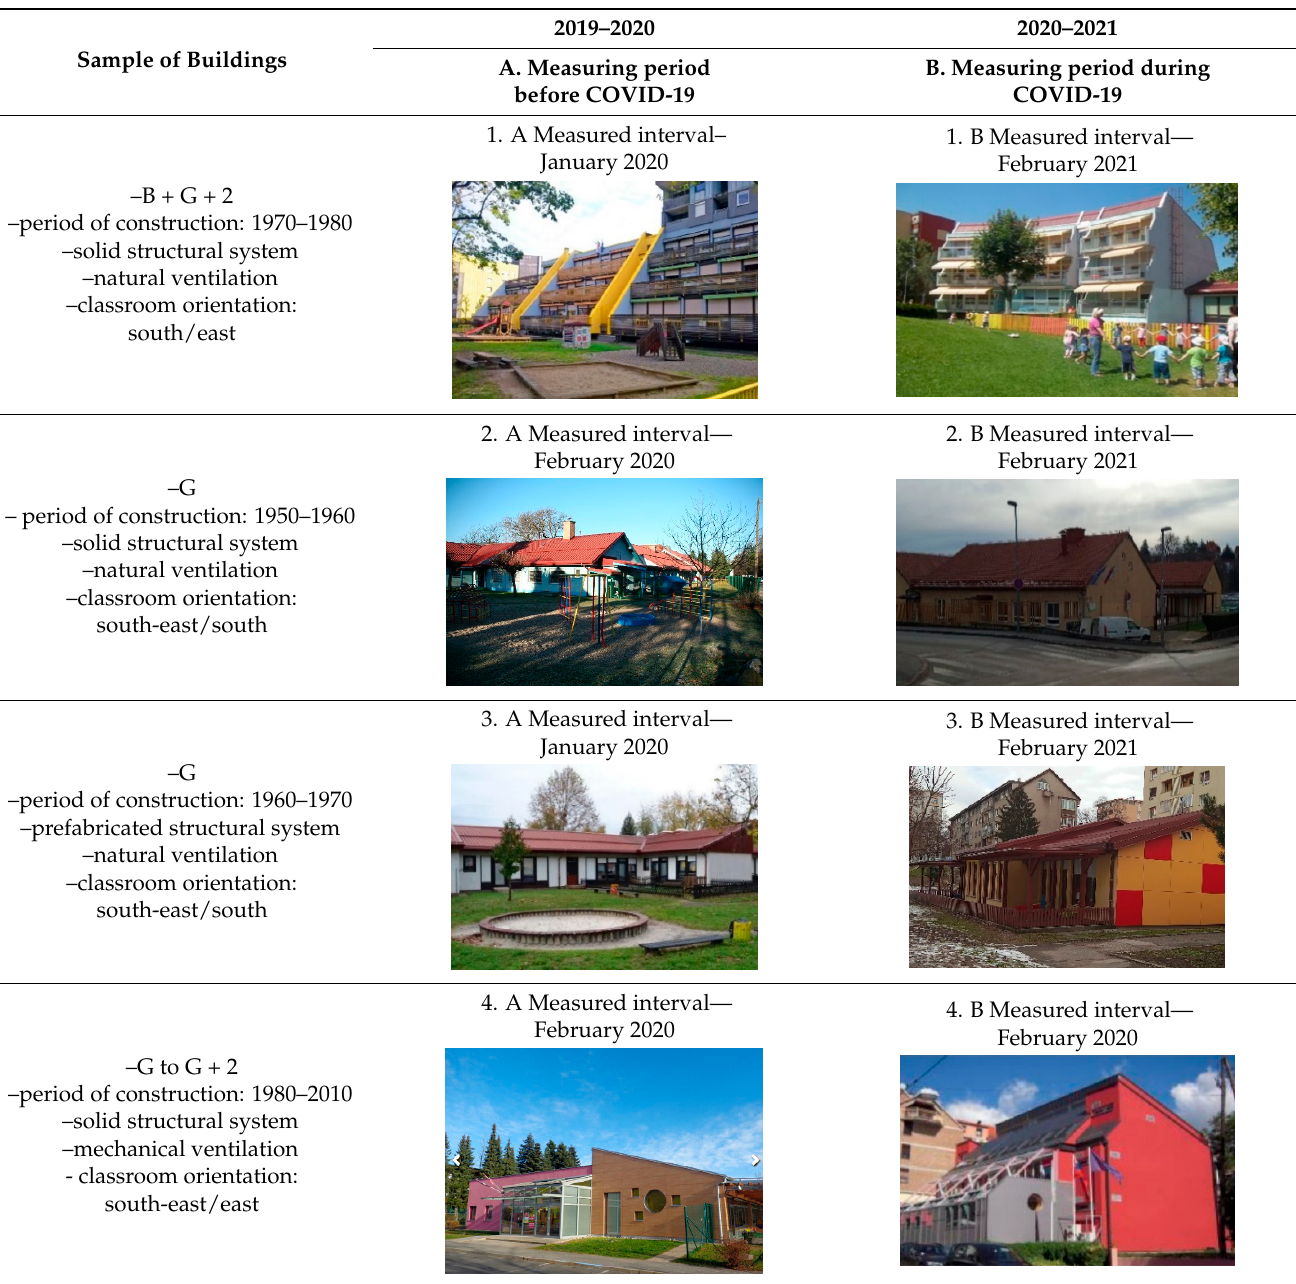
Table 3. Case Study Buildings (B—basement, G—ground floor, B + G + 2—basement + ground floor + 2 stories).